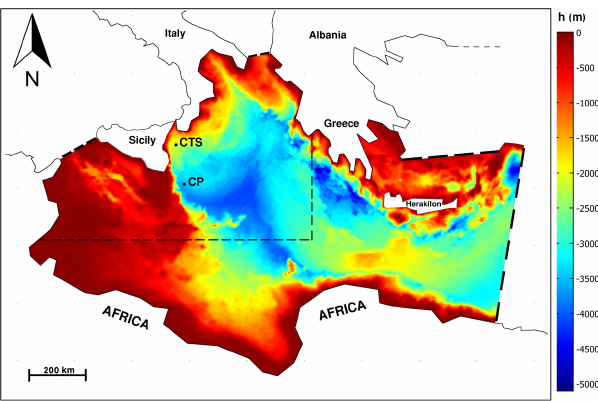
Figure 1. Mediterranean Sea bathymetry relative to the numerical